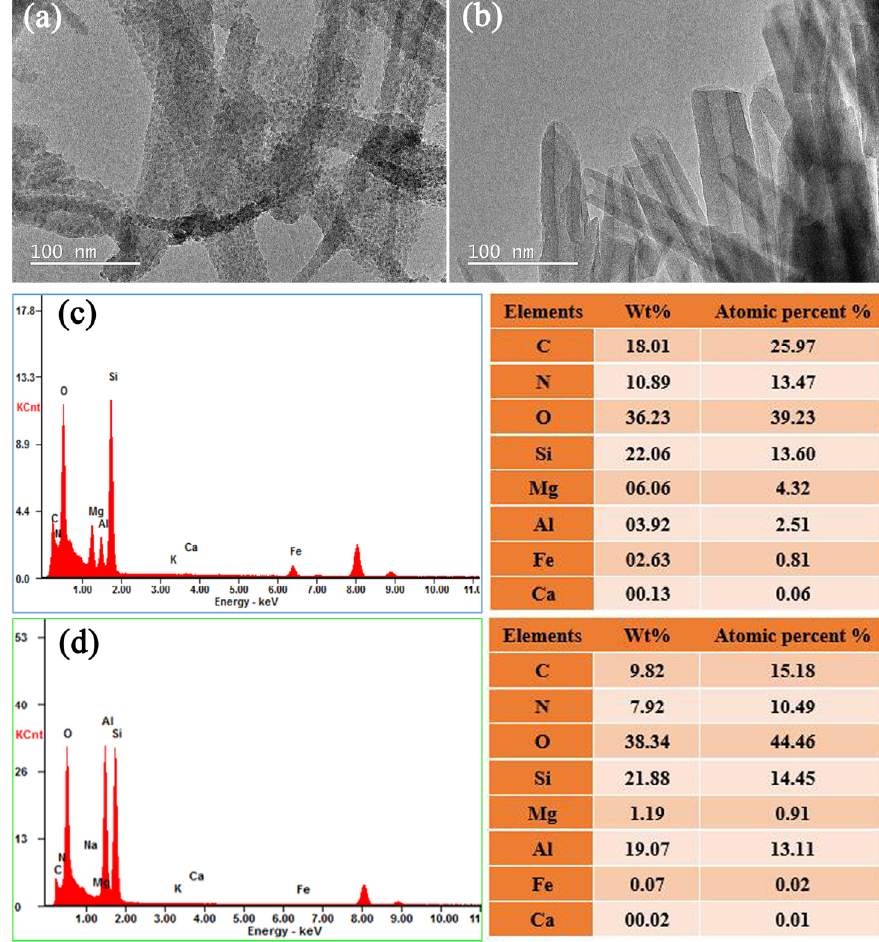
Figure 1. TEM images and EDS spectra of ( a , c ) betanin / Pal, and ( b , d ) betanin / Hal hybrid materials. Table 1. Pore structural parameters of the raw clay minerals and hybrid materials.